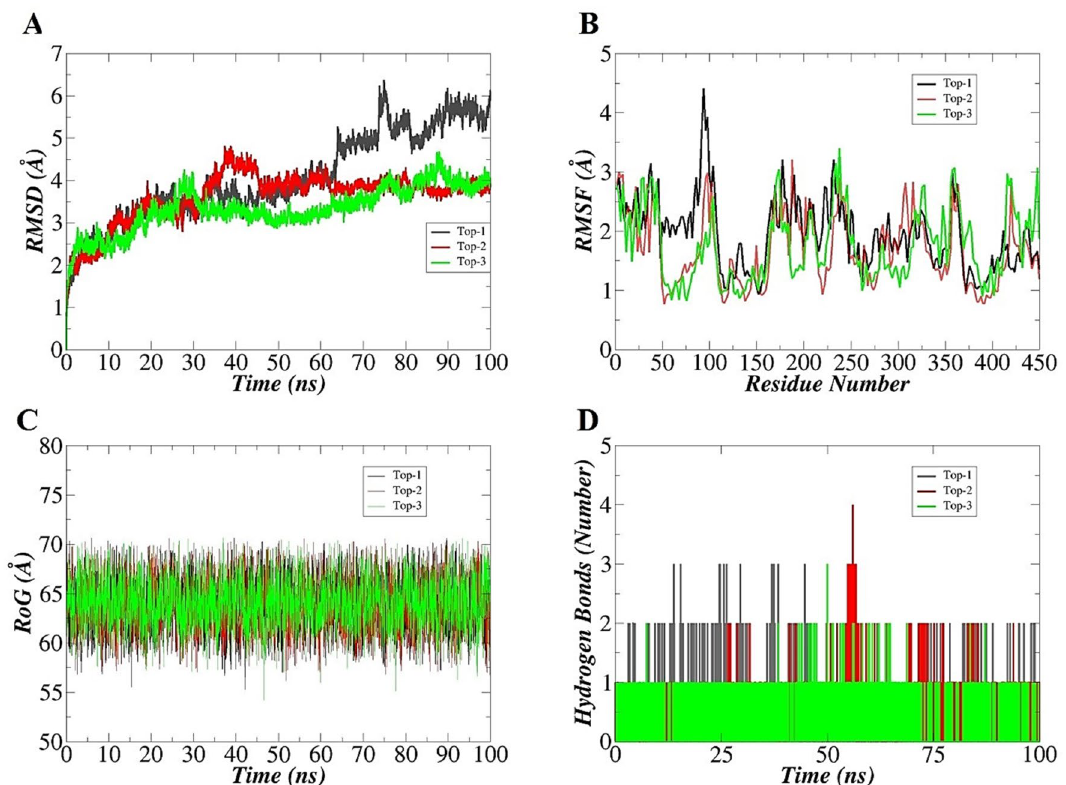
Figure 5. Investigating docked conformational stability of enzyme-compounds complexes in dynamics via different statistical parameters. ( A ) RMSD, ( B ) RMSF, ( C ) RoG, and ( D ) hydrogen deviations. The mean RMSD of control system is 2.4 Å wile mean RMSF is 2.3 Å. The EPSP synthase RMSD and RMSF in the presence of control is given I Fig. 6A, B, respectively. Inter molecular interactions RDF analysis. RDF is a pair correlation function that estimates the den- sity distribution of interacting radii significant in holding the ligand at the docked site 55,73 . RDF plots for key hydrogen bonding residues were generated to get an insight into the interatomic association of said interactions during simulation period (Fig. 7). For Top-1, two interactions engaging Ser238 and Arg399 residues were plotted that were revealed to be consistent in terms of density distribution. Two maximum density distribution points were observed for Top-1 oxygen atom and Arg399; first at 1.48 Å with g(r) of 0.51, followed by second distribu- tion at 1.62 Å with g(r) of 0.50. For the second interaction of Top-1, Ser238 is attached to the compound with maximum interatomic distribution of 0.28 at a distance of 1.36 Å. It can be concluded from both interactions plot that said interactions are vital for keeping the ligand in close vicinity of the active pocket. Top-2 interac- tion with Ser239 played less contribution with variable g(r) values at different distances, though the interaction seems to play a critical role in compound recognition and binding. Interaction with Arg399 is more stable and density distribution is maximum at 2.16 Å with g(r) value of 0.40. Top-3 compound contact with Arg197 is more uniform at a distance of 2.6 with g(r) score of 0.28. All these plots suggest high affinity binding of the compounds to enzyme and formation of strong stable complexes. As interactions distance patterns between the compounds and enzyme active site residues are not much affected during simulation time, it can be inferred that bind- ing mode of the compounds is not changed at the enzyme active pocket. As a result of which the interactions network of the compounds with respect to the enzyme remain consistent and in close distance based on which higher affinity of the compounds for the enzyme can be interpreted. Binding free energies estimation. To validate the affinity of compounds to EPSP, post simulation pro- cessing of MM-PB/GBSA was performed to yield different free energies of the complexes. MM-PBSA and MM- GBSA are considered reliable for this purpose as they are more accurate compared to docking predictions 27 . The MM-PBSA is computationally expensive than MM-GBSA but more reliable and accurate. Both methods were used to cross validate the findings. Table 1 tabulated the different binding free energies calculated by MM- PBSA and MM-GBSA methods. In MM/GBSA, the net binding free energy of the systems is −50.99 kcal/mol for Top-1, −49.5 kcal/mol for Top-2, and −46.54 kcal/mol for Top-3. In MM/PBSA, the total binding energy is −13.82 kcal/mol, −12.65 kcal/mol and −14.41 kcal/mol for Top-1, Top-2 and Top-3, respectively. In both meth- ods, the net electrostatic energy, van der Waals and non-polar solvation energies have positive contributions to the net binding energy whereas the polar solvation energy is less favorable in complex formation. The control